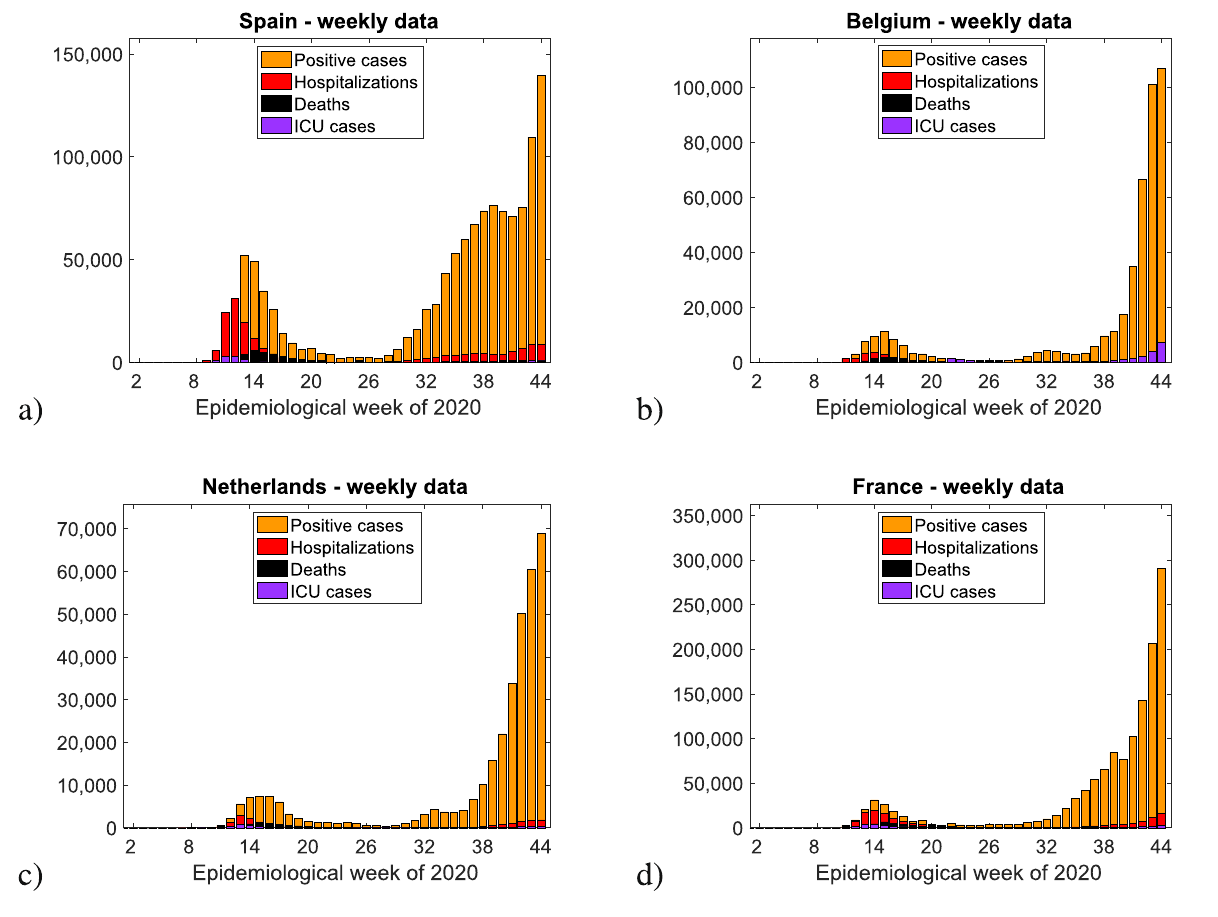
Figure 6. Weekly positive cases, hospitalizations, ICU cases, and deaths in ( a ) Spain, ( b ) Belgium, ( c ) the Netherlands, and ( d ) France until the end of epidemiological week 44 (October 31) of 2020. Only the European Countries where the complete information was available are shown. However, when looking at hospitalizations and deceased cases only, similar behaviour was also found for Germany, Portugal, Sweden, Denmark and